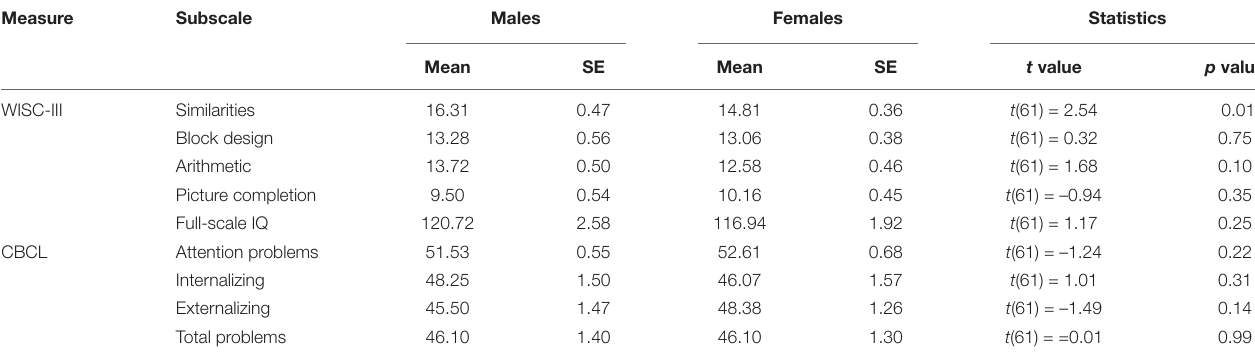
TABLE 1 | Behavioral data comparisons between groups (males vs. females).